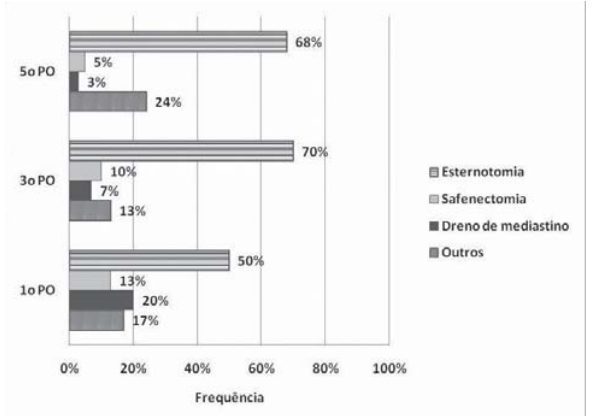
Fig. 1 - Distribuição da dor no período pós-operatório. 1ºPO = primeiro dia de pós-operatório; 3ºPO = terceiro dia de pós- operatório; 5ºPO = quinto dia de pós-operatório